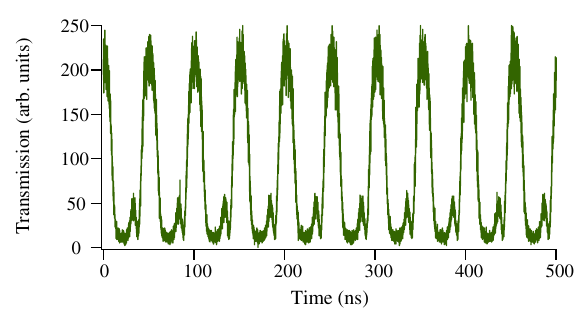
FIG. 12. Optical gating efficiency for preliminary test of the deflector scheme.